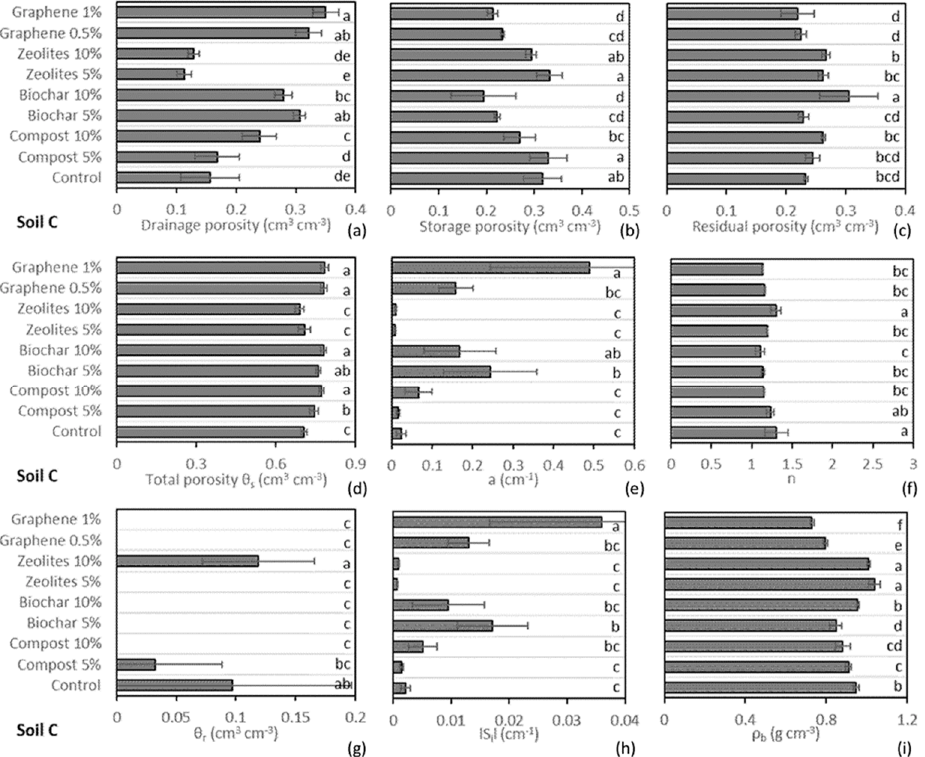
Figure 7. Mean ± st. dev. of drainage ( a ), storage ( b ), residual ( c ), and total (measured θ s ) porosities ( d ), fitted van Genuchten parameters ( e – h ), and ρ b ( i ) with the statistical LSD comparison between treatments for each parameter of Soil C. The same letter indicates no statistical differences among treatments. Table 3. Two-way ANOVA of soil types and treatment e ff ects on di ff erent porosity a tt ributes, van Genuchten parameters, and ρ b .